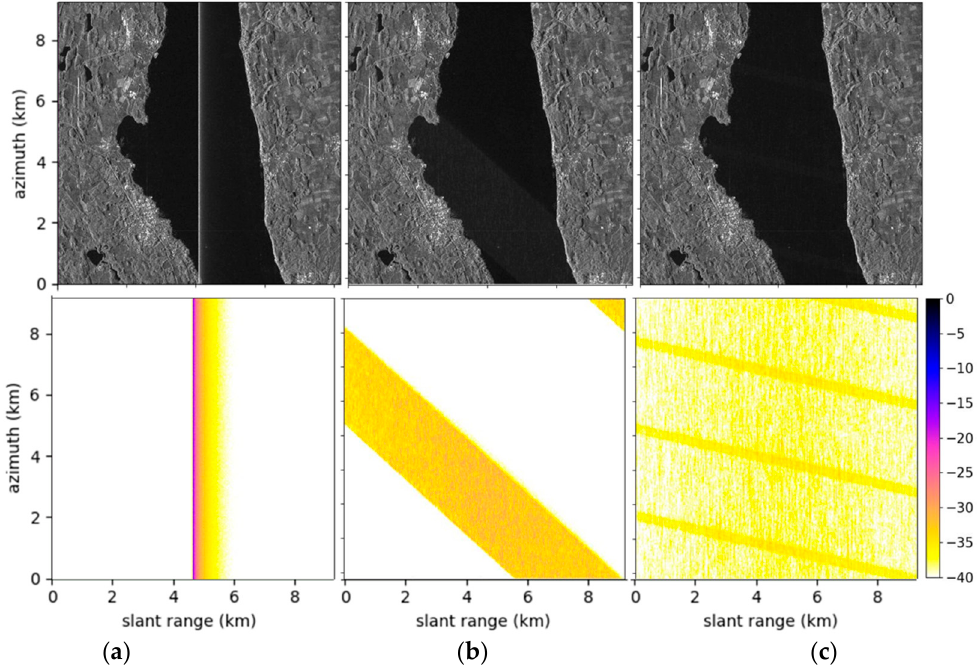
Figure 12. Focused images for ( a ) conventional SAR, ( b ) cyclically shifted chirp sequence with K = 1, and ( c ) cyclically shifted chirp sequence with K = 5 showing ( Top ) both the scene and the nadir echo displayed in linear scale and ( Bottom ) nadir echo only displayed in dB.